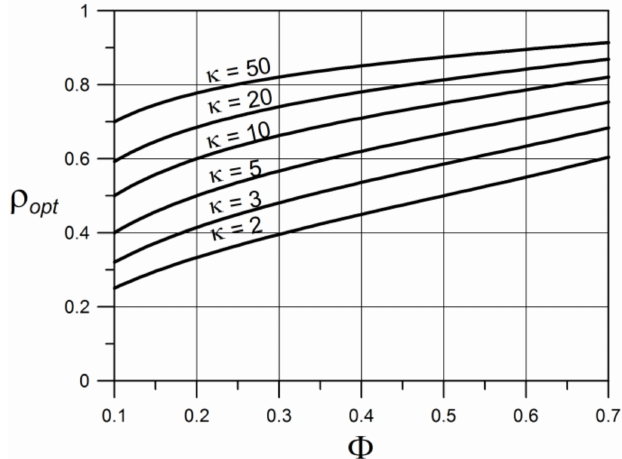
Figure 12. Dependence of dimensionless thermal resistance (at the optimal location of ATI layer) on the dimensionless temperature and pricing parameter.